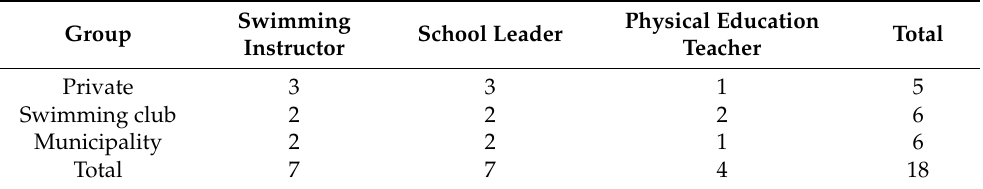
Table 1. Definition of kinematical variables chosen for analysis.